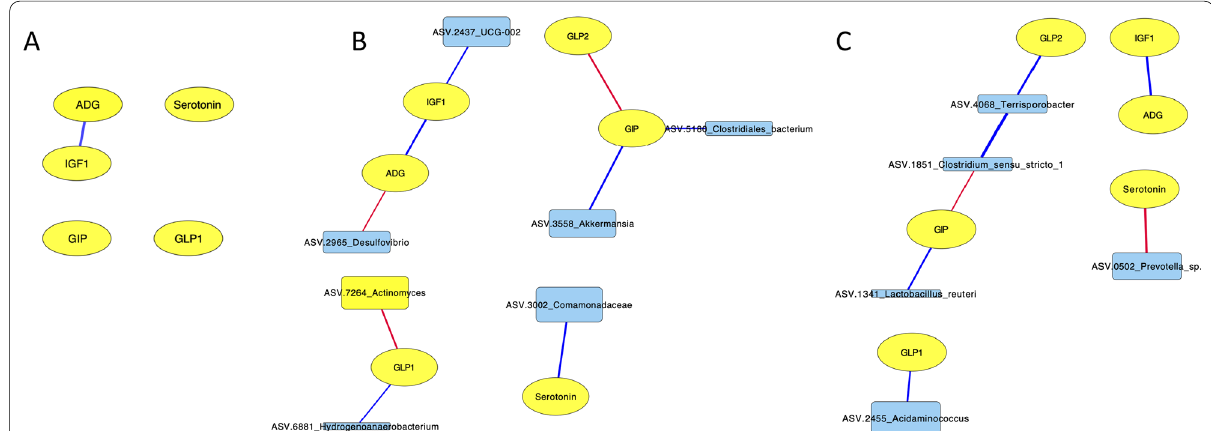
Fig. 5 A – C Network plots of microbiota associations with peptides and average daily gain (ADG). Legend: Network plots showing direct associations among ASVs, peptides and ADG at time points ( A ) day 1, ( B ) day 21 and ( C ) day 35 using the FlashWeave program. Only significant associations between ASVs and metadata variables are shown ( P < 0.01, FDR corrected). Edge color indicates association: negative (red), positive (blue); edge thickness indicates association weight. ASV node size is proportional to the mean centered log ratio